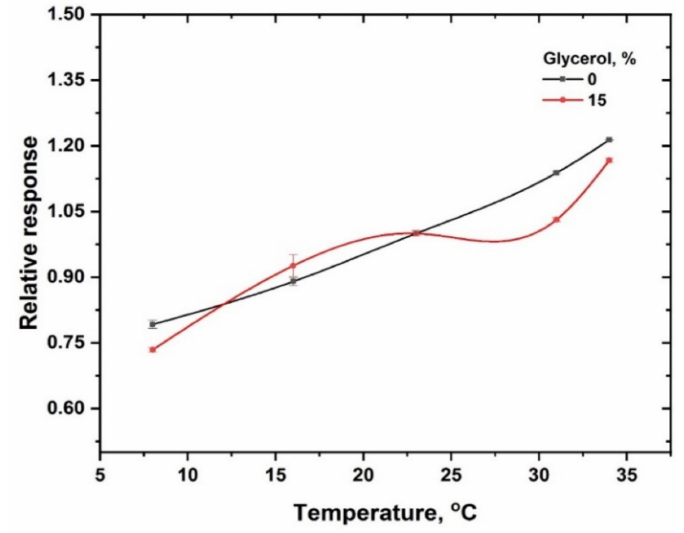
Figure 7. Variation of OA at 453 nm normalized to the value at room temperature as a function of irradiation temperature. The solid lines are a guide for the eye obtained using a basis spline function.